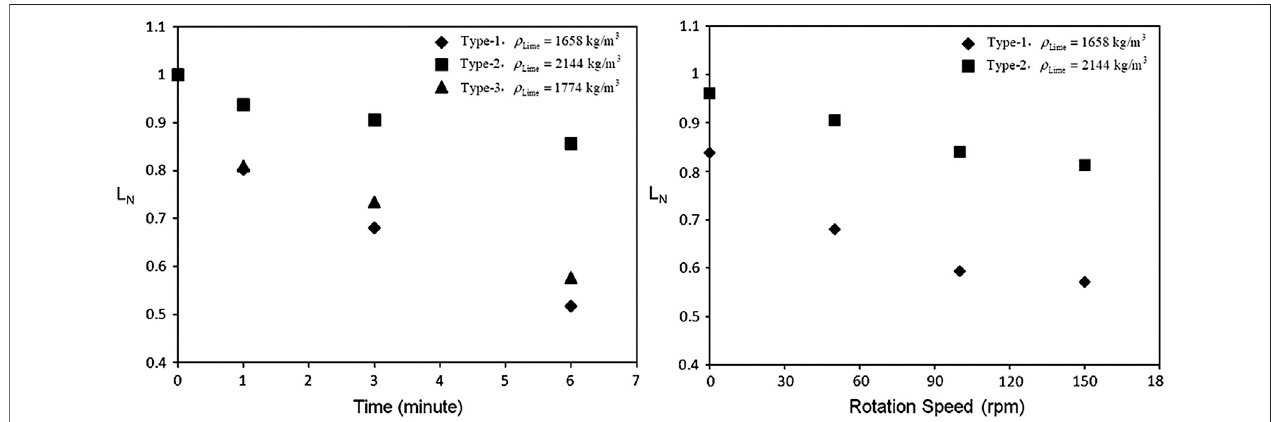
FIGURE 4 | Dissolution behavior of cube lime with various densities by (Deng and Du, 2012) [Figure 1 of (Deng et al., 2012), Copyright Springer].